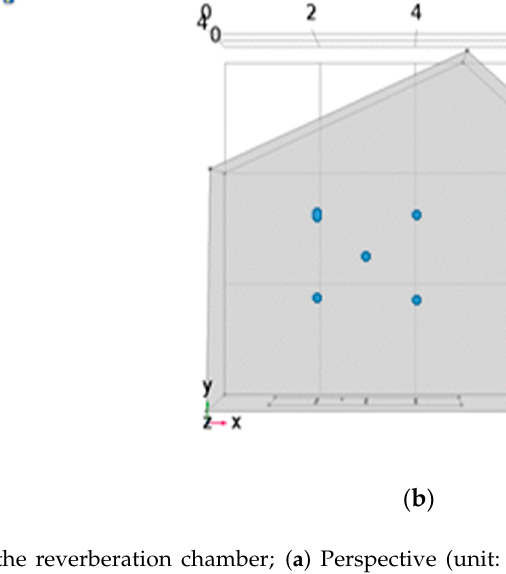
Figure 2. Modeling of the reverberation chamber; ( a ) Perspective (unit: m). The red triangle indicates the point of impact hammer, and the nine black points indicate the accelerometer locations. ( b ) Plane (unit: m). The five blue marks indicate the location of microphones for measuring sound from vibration to verify indoor acoustic characteristic.